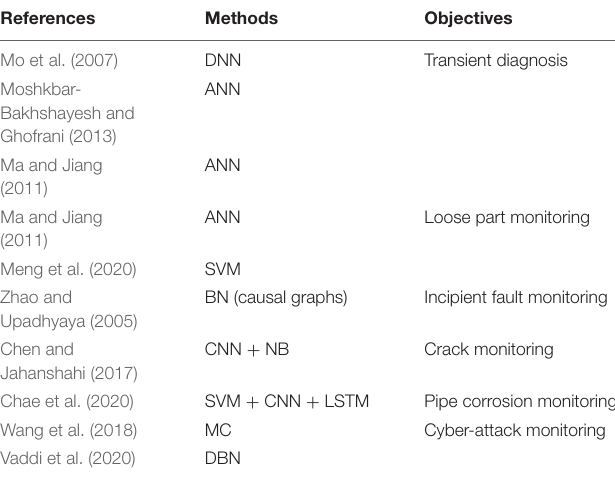
TABLE 6 | Latest applications of the data-driven machine learning (DDML) for the fault diagnosis and detection (FDD) of the nuclear power plant (NPP) condition